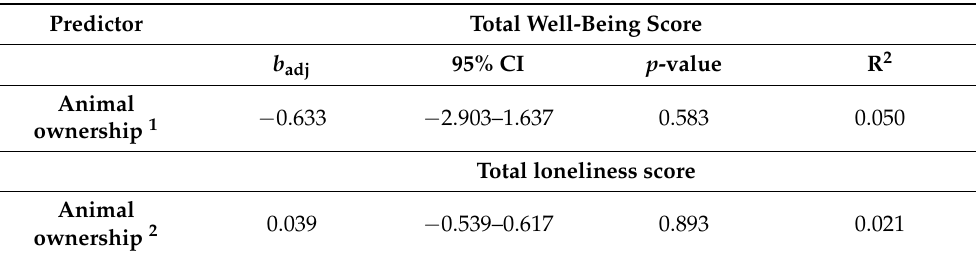
Table 2. Linear regression models of association of animal ownership and well-being and loneliness scores, adjusting for relevant